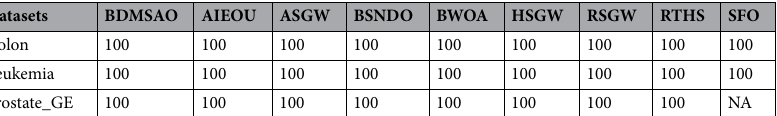
Table 10. Classification accuracy produced by BDMSAO and other FS methods on high-dimensional datasets.